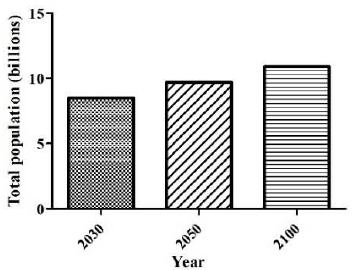
Figure 1. Estimative of total world population up to 2100.